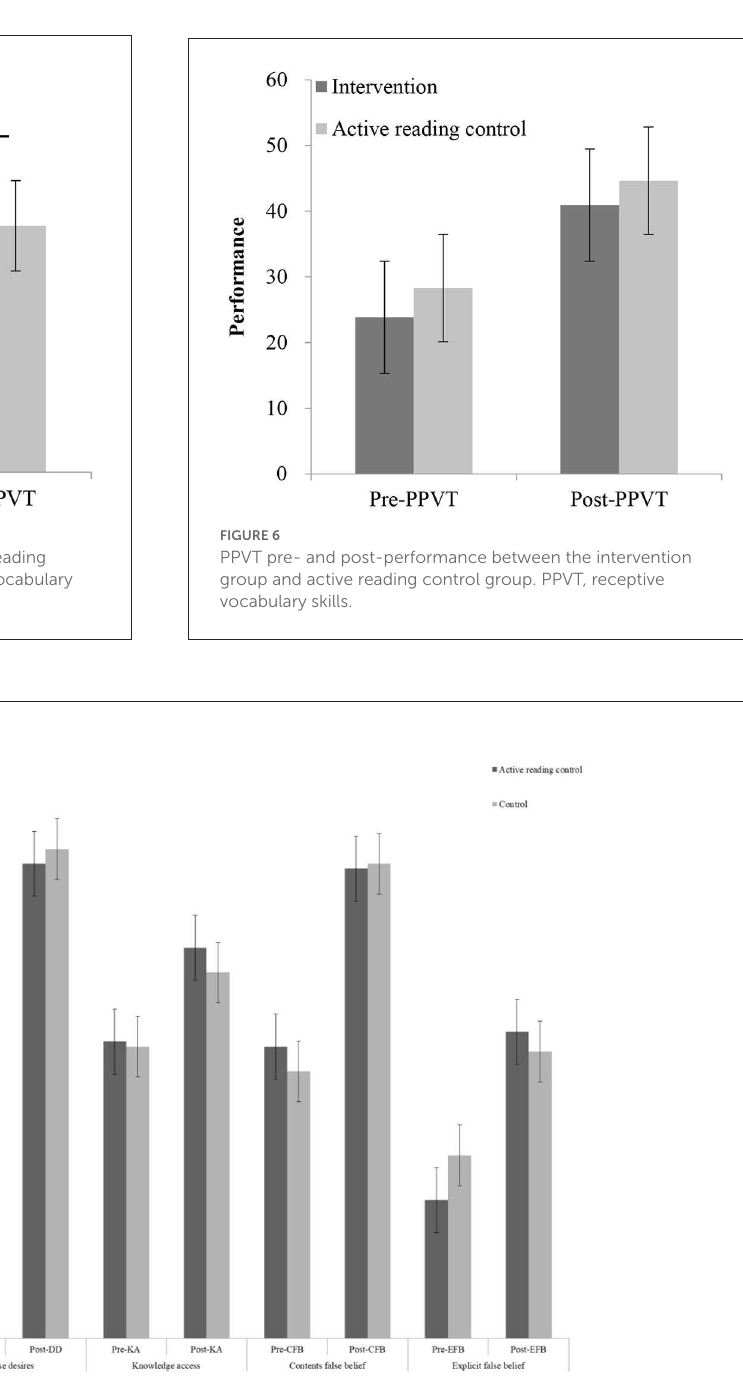
FIGURE5 Cognitive and social-cognitive pre- and post-performance between active reading control group and control group. Stroop, inhibitory control; DD, diverse desires; KA, knowledge access; CFB, contents false belief; EFB, explicit false belief, * p <